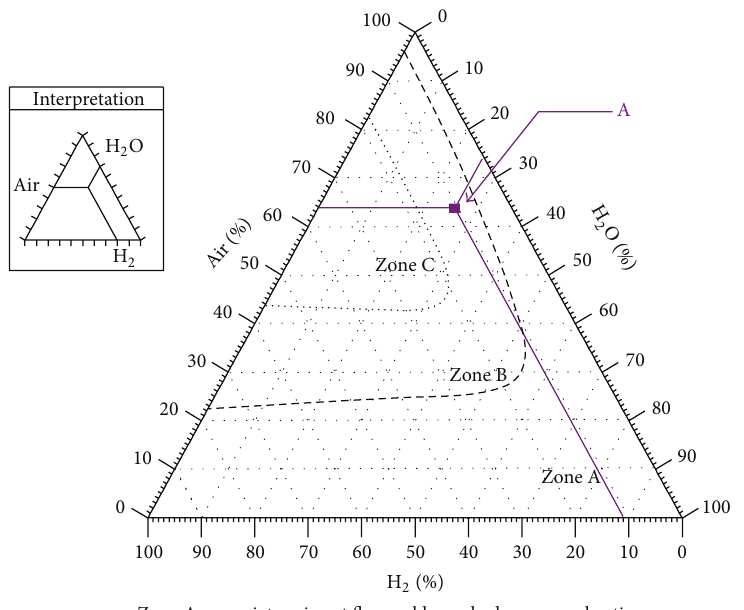
Figure 3: Shapiro diagram [8].